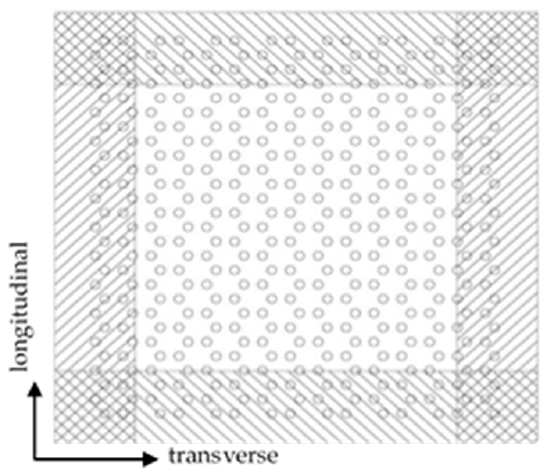
Figure 3. Pre-punched plate of performance-optimized multi-axial geogrid. Table 1. Stretching process parameter of performance-optimized multi-axial geogrid. Parameters Set Value Material Industrial